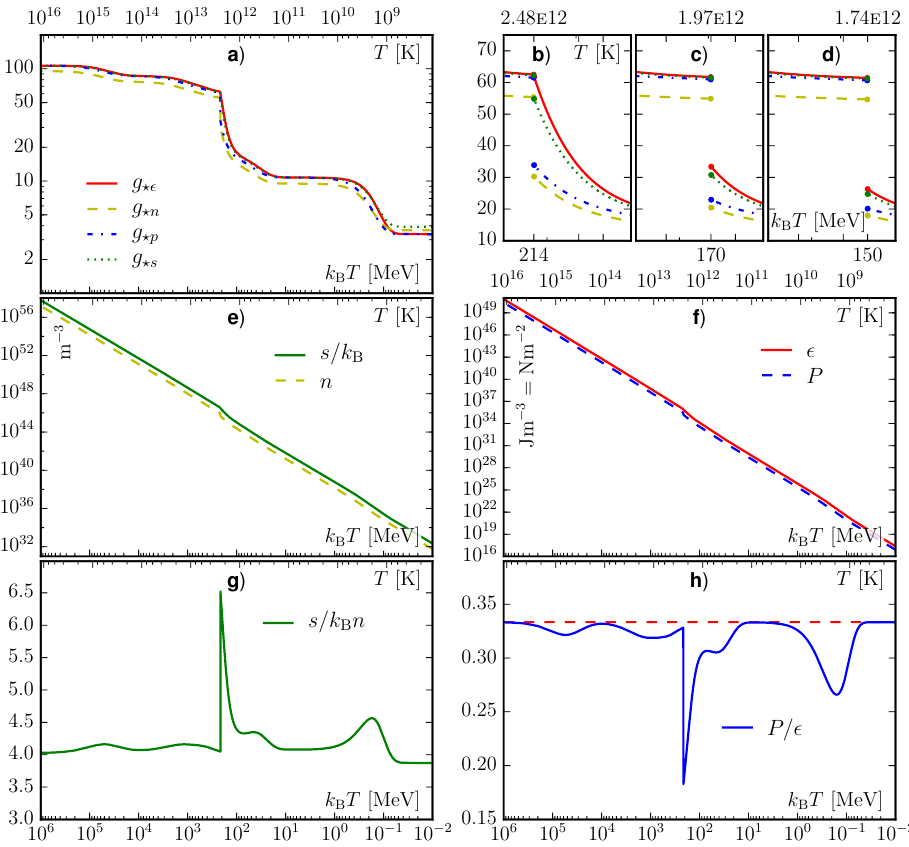
Figure 6. Panel ( a ) shows the four g ⋆ s. At k B T = 214 MeV, only g ⋆ (cid:101) is continuous, while g ⋆ n , g ⋆ p , g ⋆ s drops in value by between 10 and 30. The three upper right panels show these jumps at transition values of 214 MeV ( b ), 170 MeV ( c ), and 150 MeV ( d ). Panels ( e ) and ( f ) show the evolution of n , (cid:101) , P , and s / k B as a function of temperature. In the two lower panels, we look at the relation between entropy density and number density ( g ) and pressure and energy density ( h ). We see small fluctuations during periods with particle annihilations, especially right after the QCD phase transition. As we remember from Figure 3, this is because the pressure and number density drop quicker than energy density and entropy density at these times. The short physical explanation is that semi- and non-relativistic particles exert less pressure and have a higher entropy than relativistic particles (at the same temperature). One consequence of this is that particle numbers are not conserved, which is not a requirement for particles whose chemical potential is